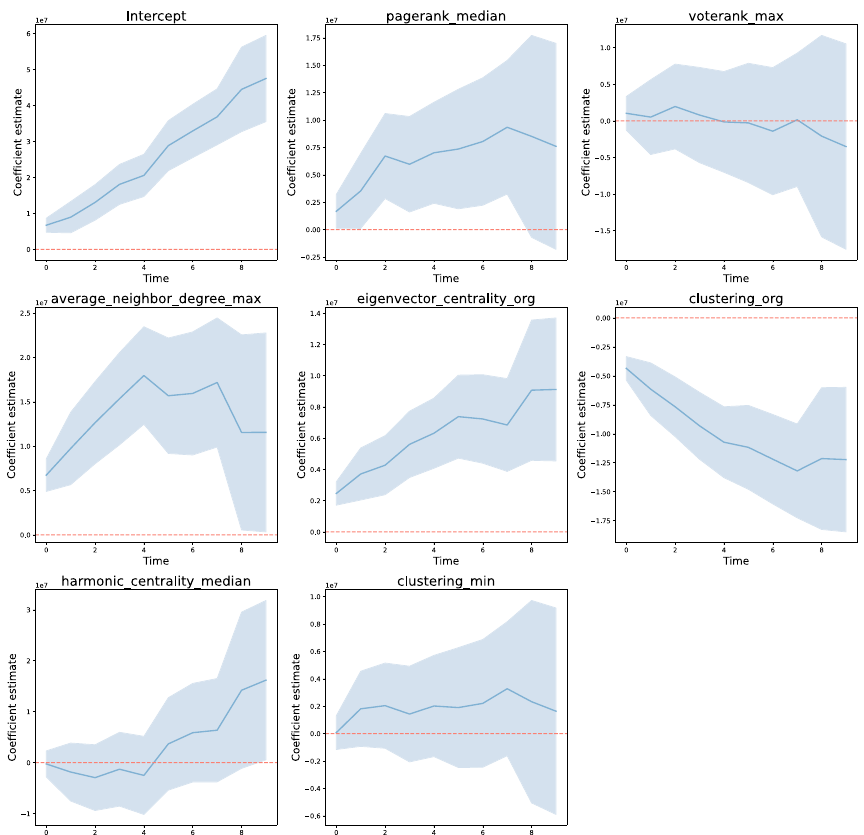
Fig. 7 Function-on-scalar regression. Blue solid lines represent coefficient curve estimates, surrounded by blue confidence bands (constructed through point-wise estimated standard errors, 95% confidence level). Red dashed lines mark 0. The estimated intercept can be interpreted as the sheer effect of